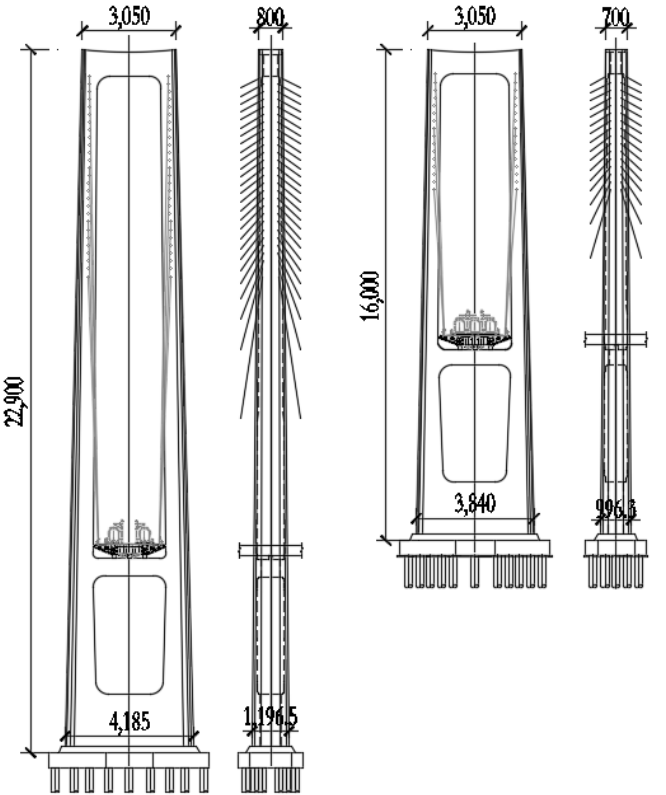
Figure 3. Cross-sectional view of the main tower (unit: mm).